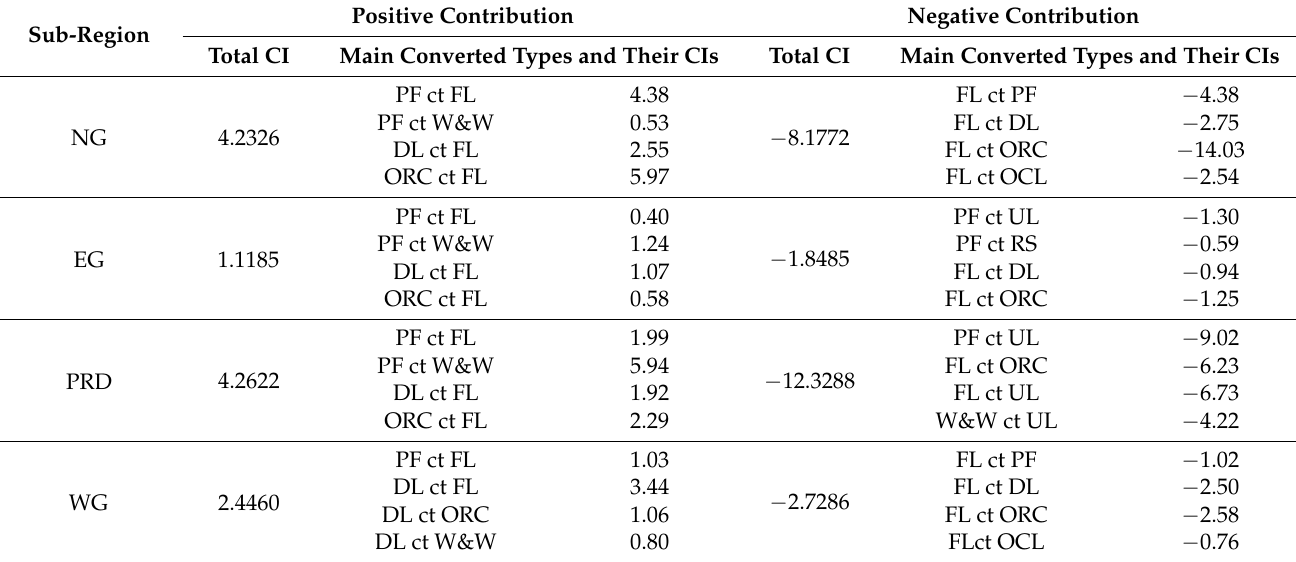
Table 5. The CIs in four sub-regions of Guangdong from 1980 to